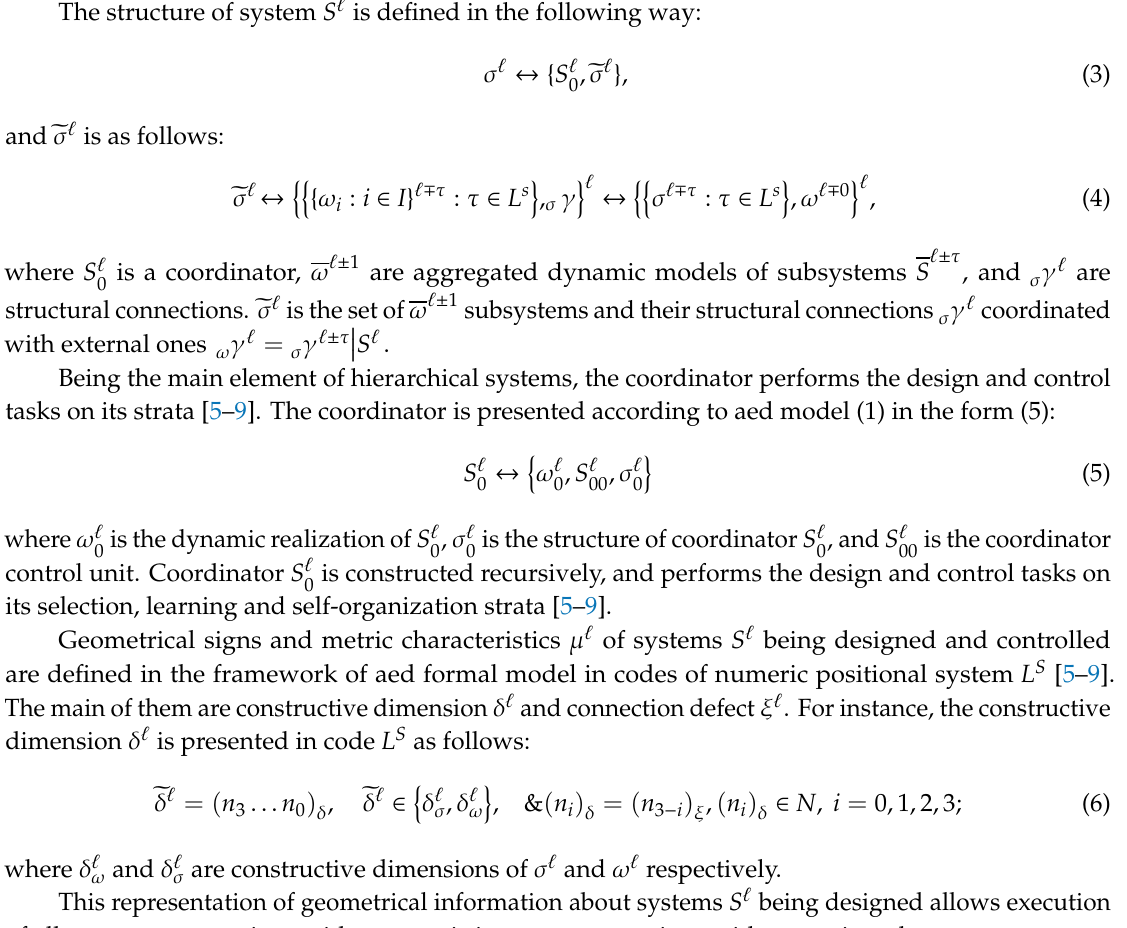
Figure 1. Structural scheme of aed—standard block of HS. S 0 is the coordinator, ε S is the environment, S i are subsystems, π S i are subprocesses, π S l is the process of level (cid:96) , X l and Y l are the input and output of mechatronic system S l ; and c i , z i , γ , w i , u i , y i are interactions.